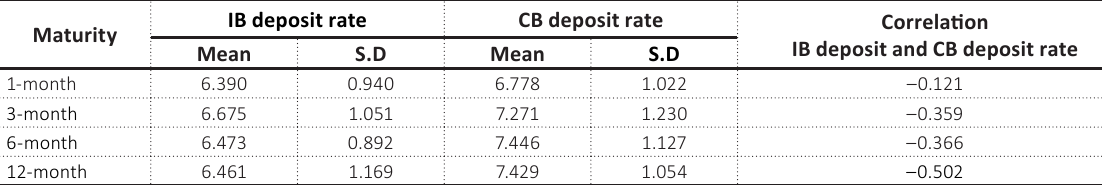
Table 2. Descriptive statistics